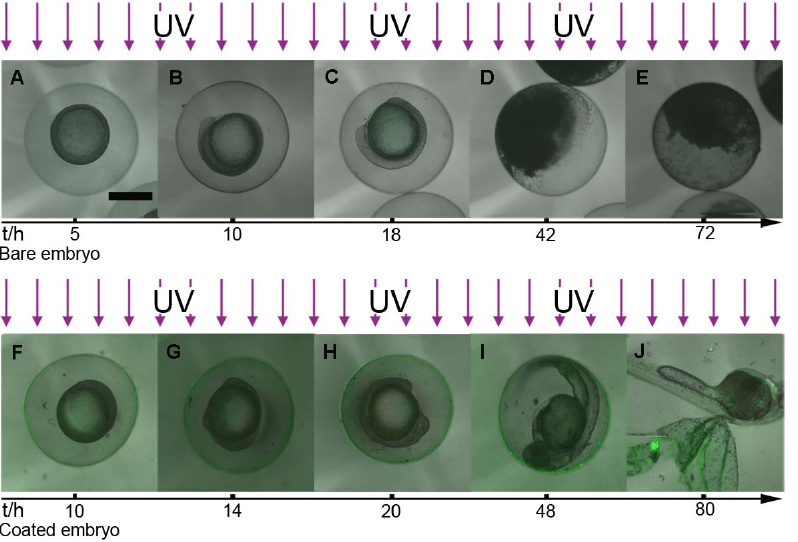
Figure 3. Parallel development stages of the bare embryo and the coated embryo under UV radiation. A–E. The development traces of the bare embryo under UVB ray. F–J. The development stages of the coated embryo under UV radiation. A, F. 30%-epiboly stage. B, G. Bud stage. C, H. 14-somite stage. D, E. Interruption of the development. I. High pectoral stage. J. Protruding-mouth stage. Embryonic development within engineering shell under UVB radiation is fulfilled and the man-made shell can be broken by the larva. Scale bar, 500 m